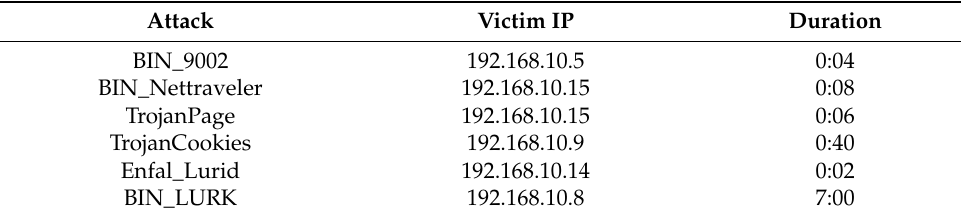
Table 1. APT attacks and mapped IP addresses.